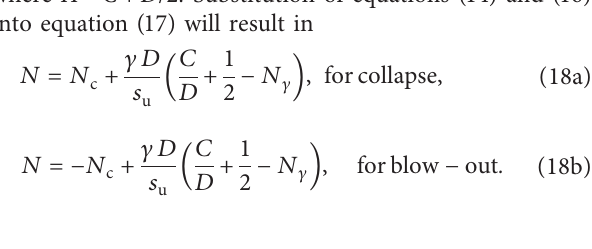
Figure 9: Layout of the derived continuous velocity field for deep tunnel blow-out ( C/D � 4, c D / s downward movement; (b) tunneling in upward